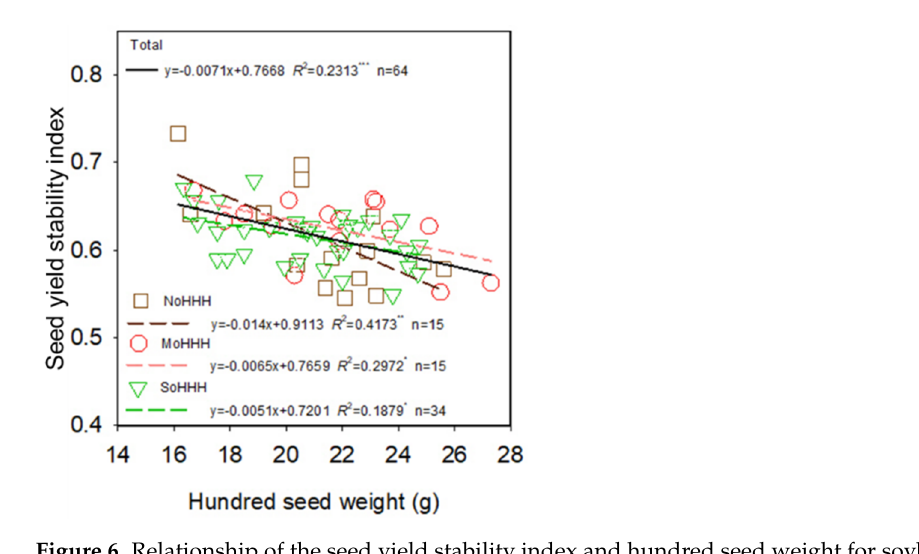
Figure 6. Relationship of the seed yield stability index and hundred seed weight for soybean. *, **, and *** indicate significance different at the 0.05, 0.01, and 0.001 probability levels, respectively. The relationships of seed protein content, seed lipids content, seed yield, and seed yield stability index with hundred seed weight of soybean were investigated. The seed protein content of soybean in HHH ranged from 36.3% to 46.7%, with mean and median values of 41.77% and 41.63%, respectively (Figure 7A). No significant ( p > 0.05) differences were found between seed protein content and hundred seed weight under any seed protein content grades (<41.63% or >41.63%) of soybean (Figure 7B). This suggests that the seed protein content of soybean was not increased with large seed sizes of cultivars in HHH.